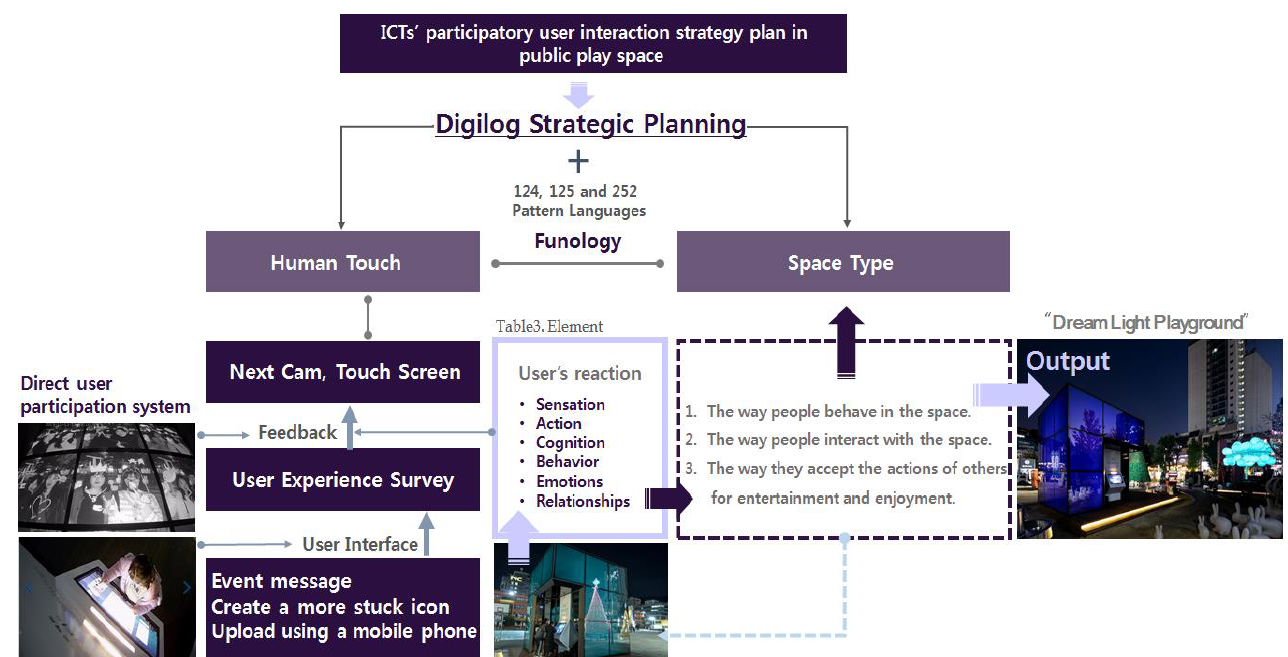
Figure 6. This example plan shows the ICTs’ Future 4th Plan public play space, splace-oriented strategy through a project